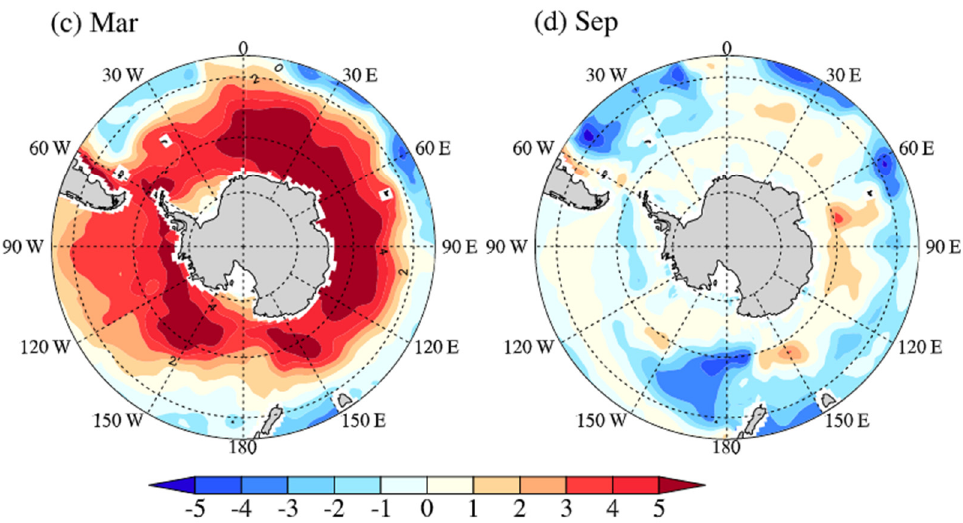
Figure 8. Spatial patterns of simulated ensemble mean in 1979–2014: ( a , b ) in the Arctic in March and September, and ( c , d ) in the Antarctic in March and September, with SST bias relative to WOA 13 [36].